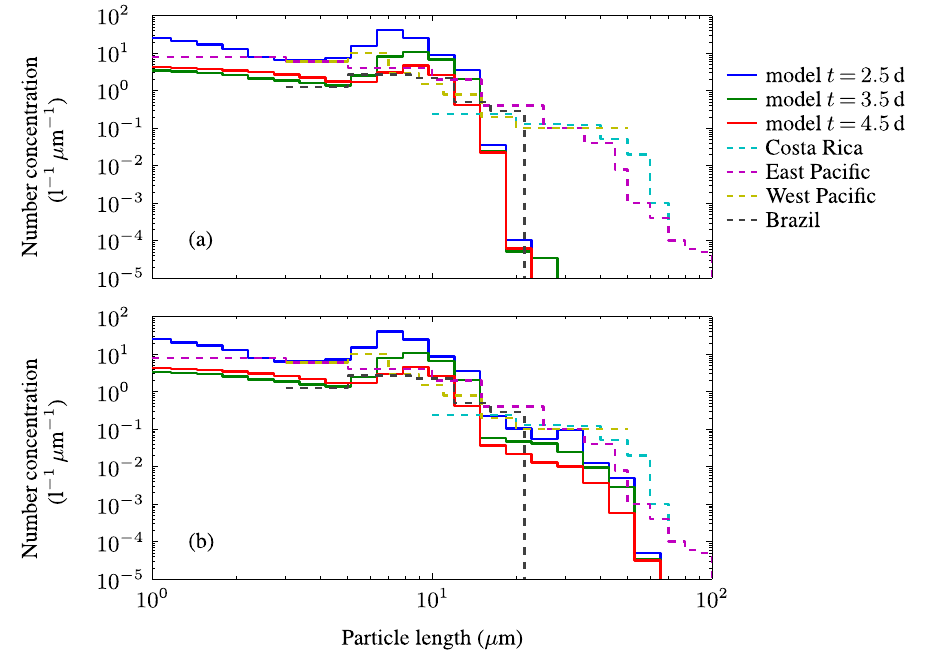
Fig. 7. Ice number size distributions from model at 2 . 5d, 3 . 5d and 4 . 5d, and observations in TTL cirrus over Costa Rica (Davis et al., 2010), East Pacific (Lawson et al., 2008), West Pacific (McFarquhar et al., 2000) and Brazil (Voigt et al., 2007). In the study of Voigt et al. (2007), the instrument was able to detect ice crystals up to about 30µm, but no crystal larger than 22µm was observed. In (a) , all ice crystals in the simulated cloud are spheres, as assumed in the bin microphysics and radiation schemes in the model. In (b) , 2% and 1% of spherical crystals in the model output are replaced respectively by plate-like and columnar